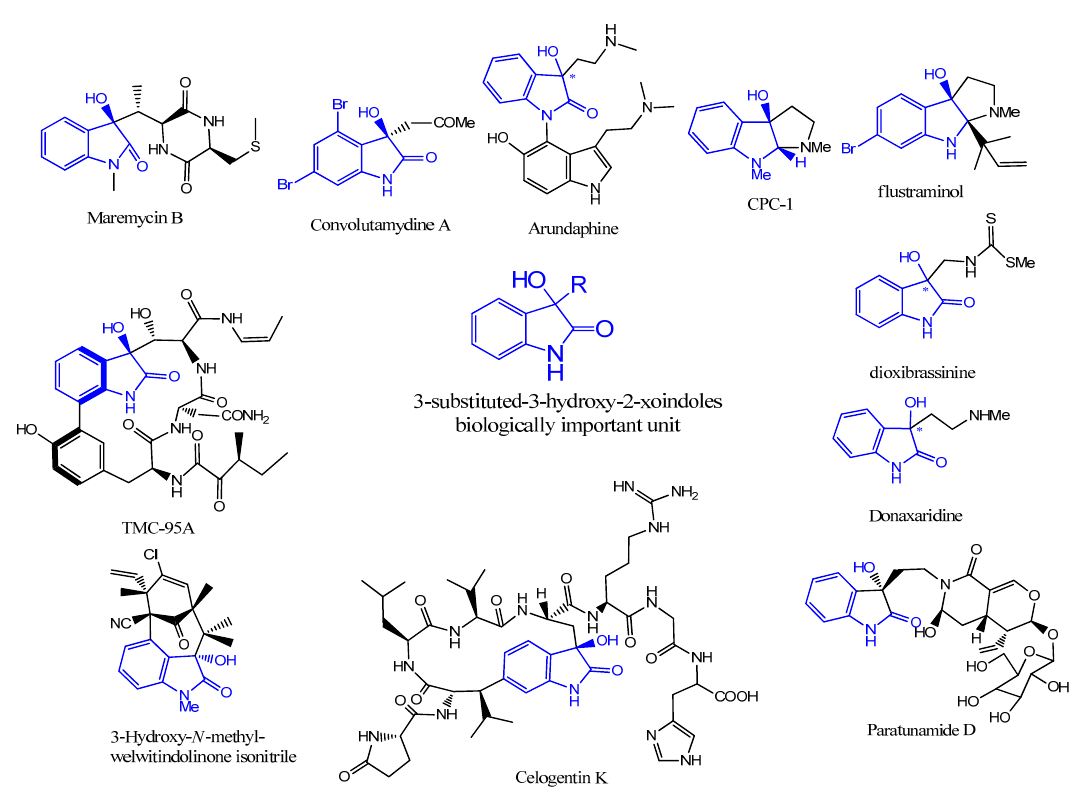
Figure 1. Biologically important molecules containing